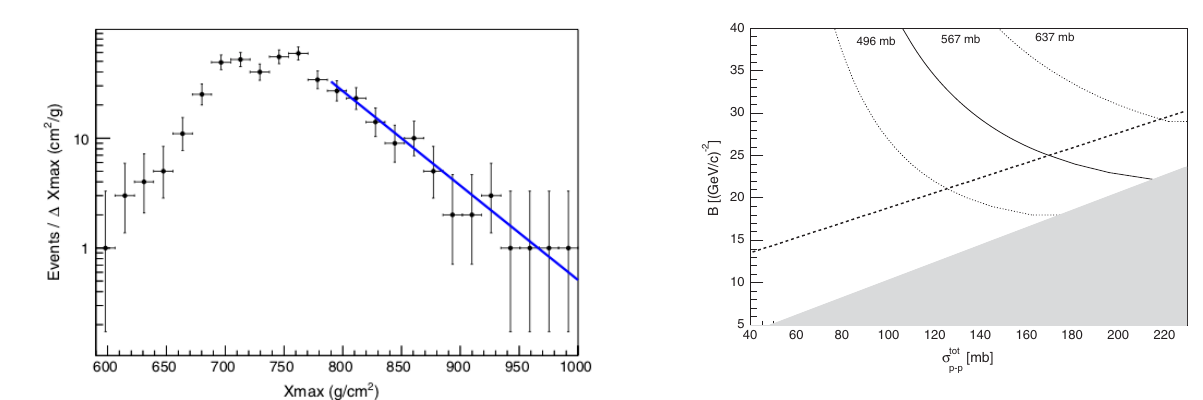
− 2 ) vs σ total p FIG. 8. The elastic slope B in ( GeV = c − p in mb. The Figure 5. The Glauber calculation to convert (cid:27) tot and B into ð Þ solid and the dotted curves are the relation between B and σ total p − p p (cid:0) p (cid:27) inel . The three curves correspond to (cid:27) inel and its errors deter- for the constant value of the measured σ inel p by the Telescope p (cid:0) air p (cid:0) air − air Array detector and the statistical error using Glauber Formalism. mined in Sec.2.2. The straight line is the BHS fit and the shaded The dashed line is the BHS QCD inspired fit [8]. While the gray area is not allowed by the unitarity limit. (Figure from [5]) shaded area is the unitarity constraint.